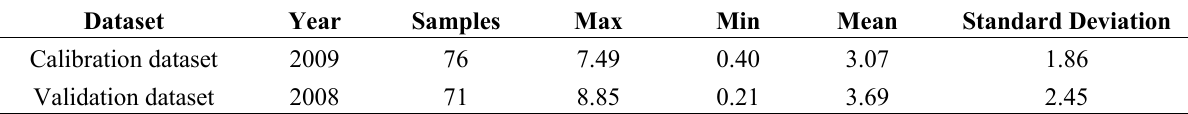
Table 1. Descriptive statistics of LAI in two years’